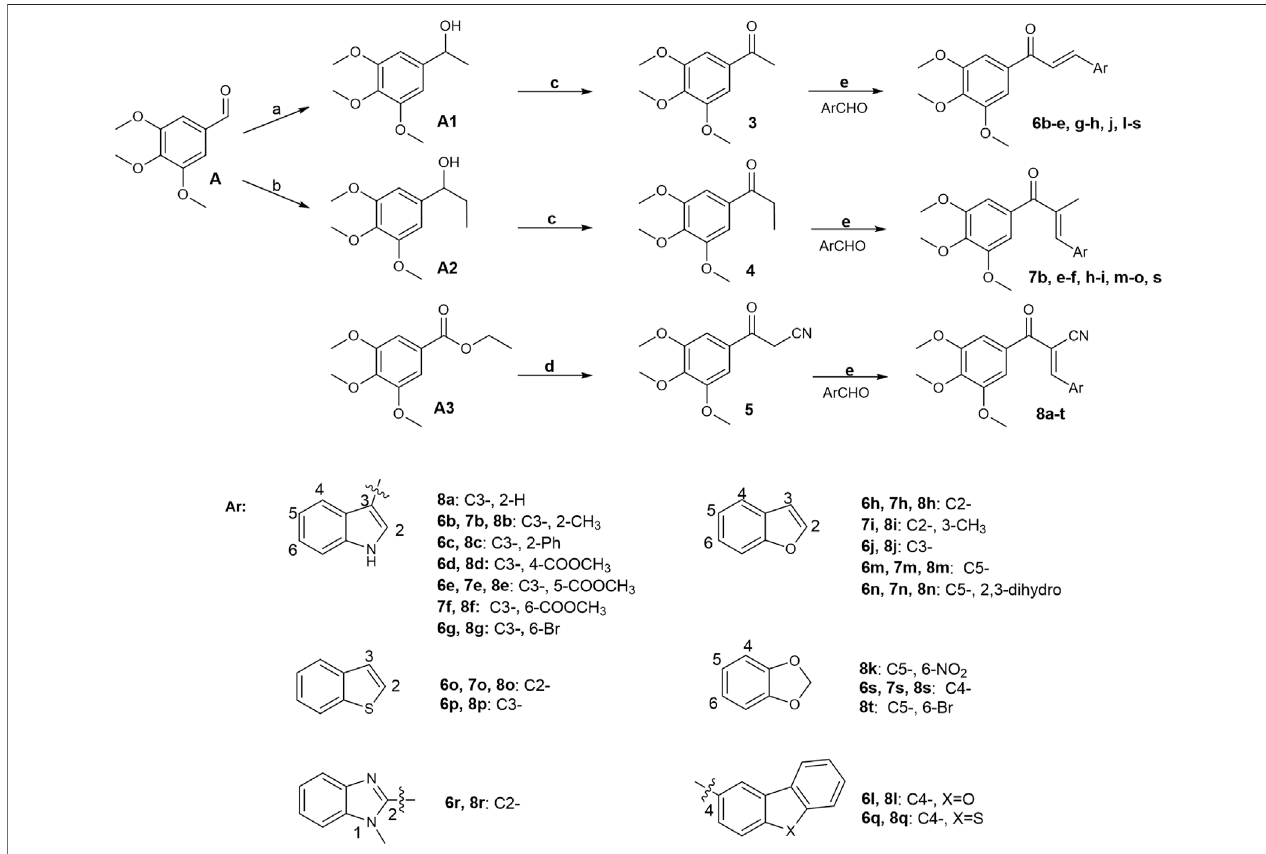
FIGURE 12 | Reagents and conditions: (A) CH 3 MgBr, THF, 0 ° C – 25 ° C; H 2 O, 81%. (B) CH 3 CH 2 MgBr, THF, 0 ° C – 25 ° C; H 2 O, 50%. (C) PCC, CH 2 Cl 2 , 0 ° C – 25 ° C; H 2 O, 74%. (D) CH 3 CN-THF (1:1), NaH, re fl ux, 81%. (E) MeOH or ethanol or THF or Dioxane, appropriate base, 0 ° C – 75 ° C, 45% –